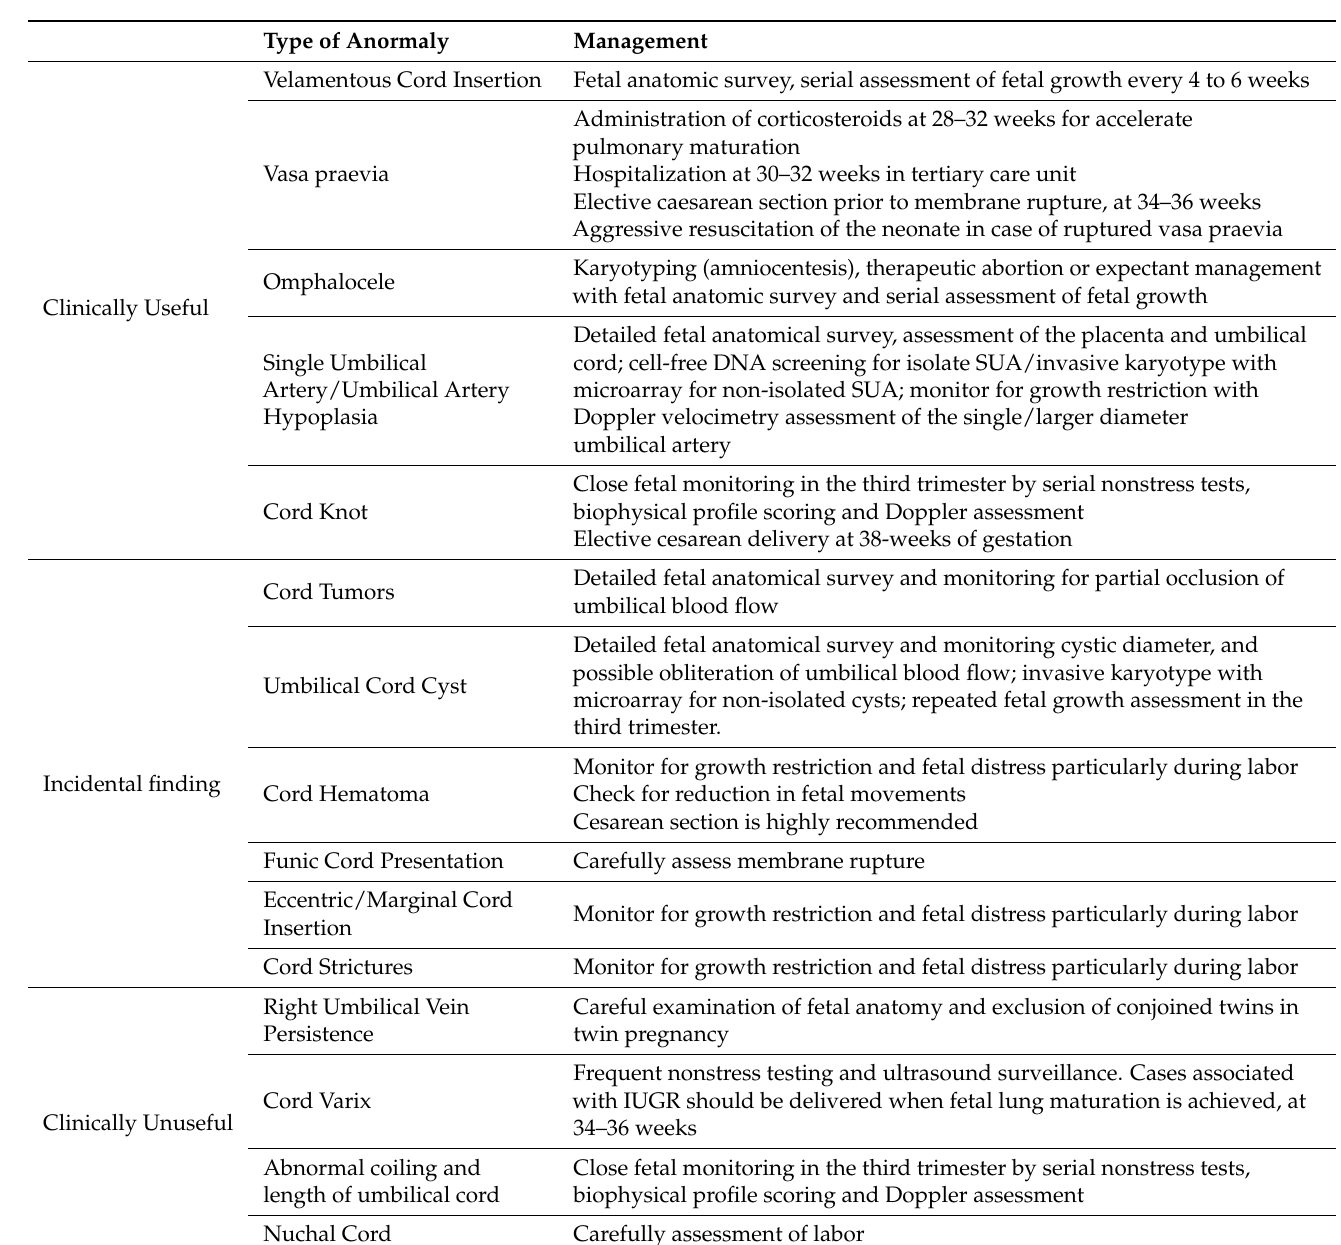
Table 3. Management of the UCA classified by clinically